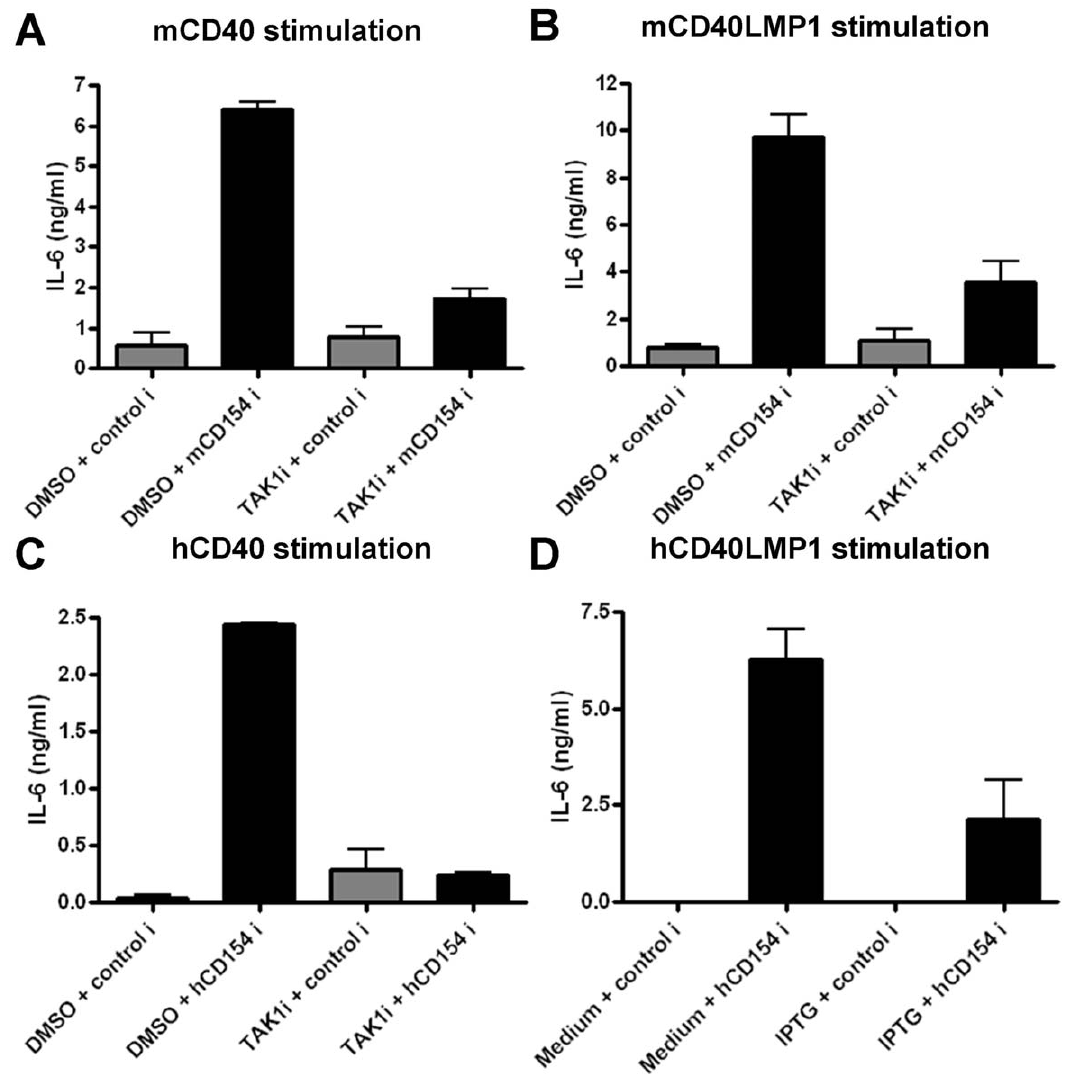
Figure 1. Role of TAK1 in IL-6 production by CD40 and LMP1. A) WT mouse splenic B cells were treated with DMSO or TAK1i prior to stimulation with control insect cells (control i) or those expressing mCD154 (mCD154 i), as described in Methods. Cells were cultured for 24 h and supernatants were collected for IL-6 ELISAs. B) Similar to panel A , except that B cells were from a mCD40LMP1 Tg mouse. C) Similar to panel A , except that human B cells were stimulated. D) Similar to panel A , except that CH12.hCD40LMP1 mouse B cells were treated with medium alone (control) or IPTG to induce DN-TAK1 prior to stimulation. Data in all panels are mean values 6 SEM of triplicate samples, and are representative of at least two independent